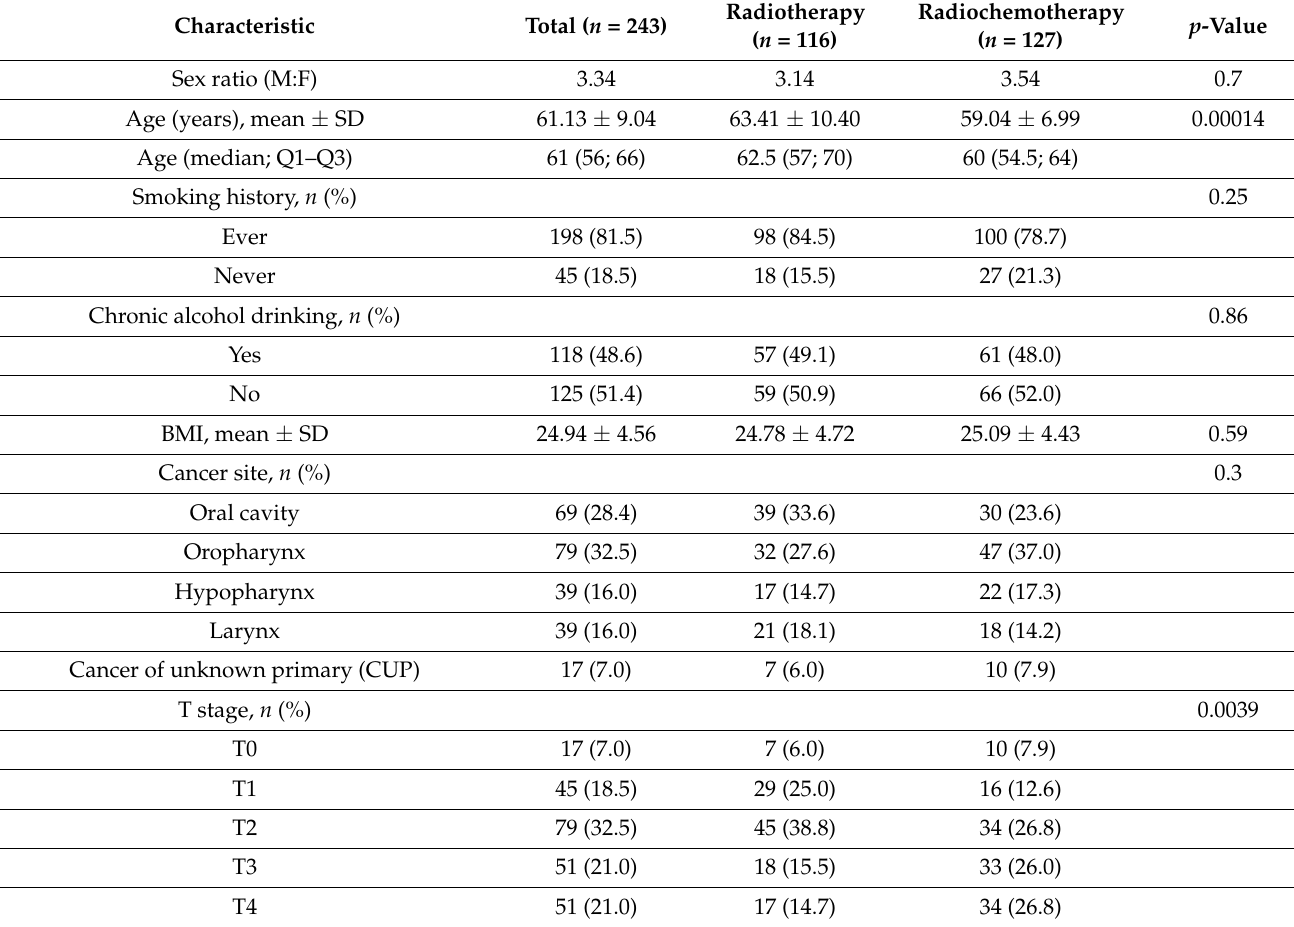
Table 1. Baseline characteristics of the patients. BMI: body mass index; WHO PS: World Health Organization performance